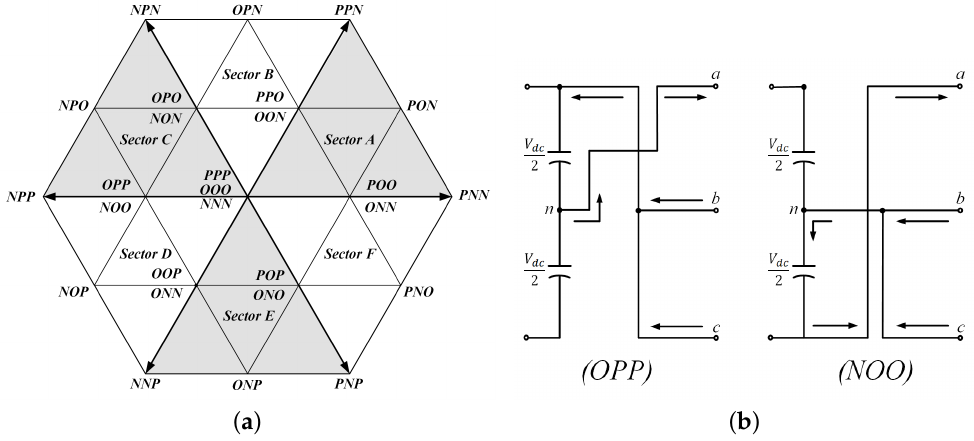
Figure 3. Switching Vector and Sector of the 3-level AC/DC converter: ( a ) Space vector pulse width modulation (SVPWM); ( b ) Small Vector OPP and NOO